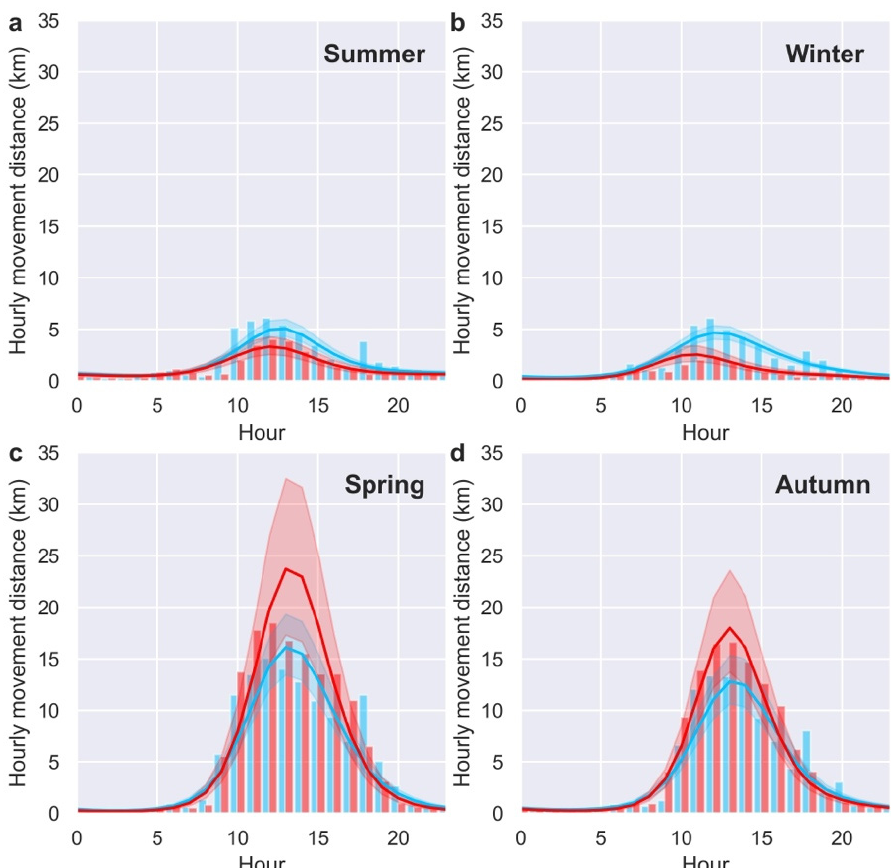
Figure 1. Average hourly movement distances of American White Pelicans with circadian hours. Blue and red colors represent wintering groups at Northern and Southern Gulf of Mexico, respectively. Panels represent ( a ) summer, ( b ) winter, ( c ) spring migration, and ( d ) autumn migration. Bars show observed average hourly movement distances. Lines indicate the estimated average hourly movement distances based on the best model. Polygons represent 95% confidence intervals of the average hourly movement distances.